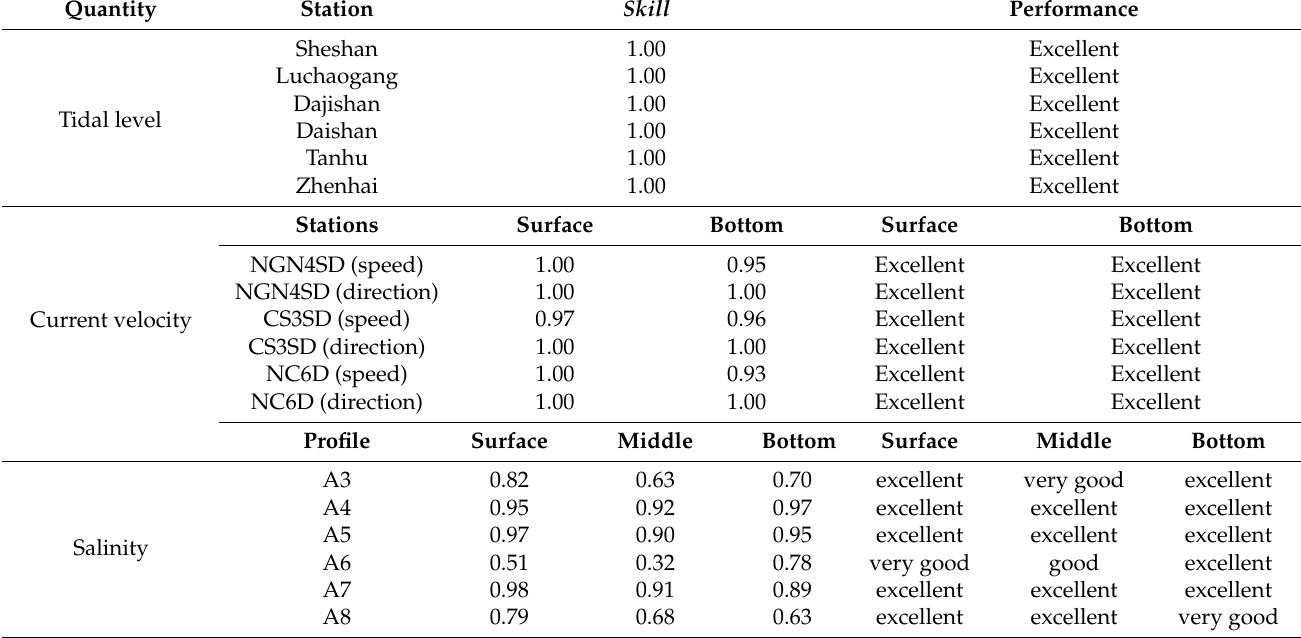
Table 1. Summary skill values of the assessment model performance.